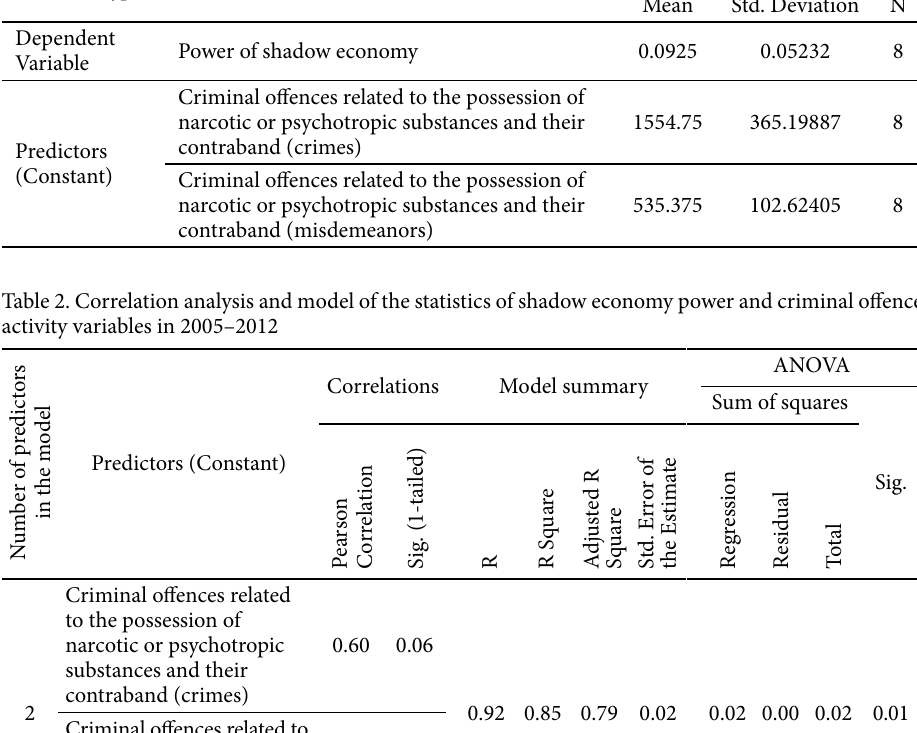
Table 1. Descriptive statistics of the variable of shadow economy power and criminal offences in 2005–2012